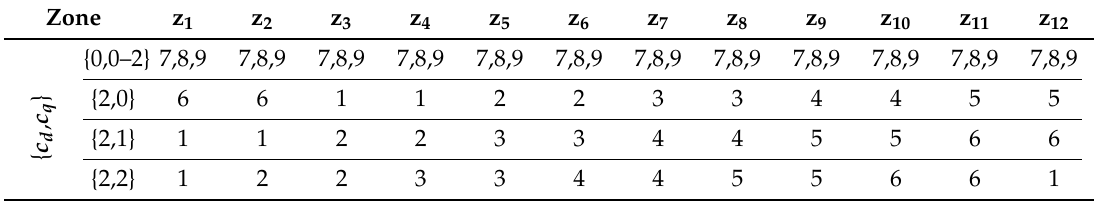
Figure 3. Current space vectors of the shunt converter with 12 zones (dashed lines). ( a ) All vectors and zones. ( b ) Vectors that can be applied in zone z 2 . Table 4. Switching vector selection for the shunt converter in function of the voltage zone and the sliding